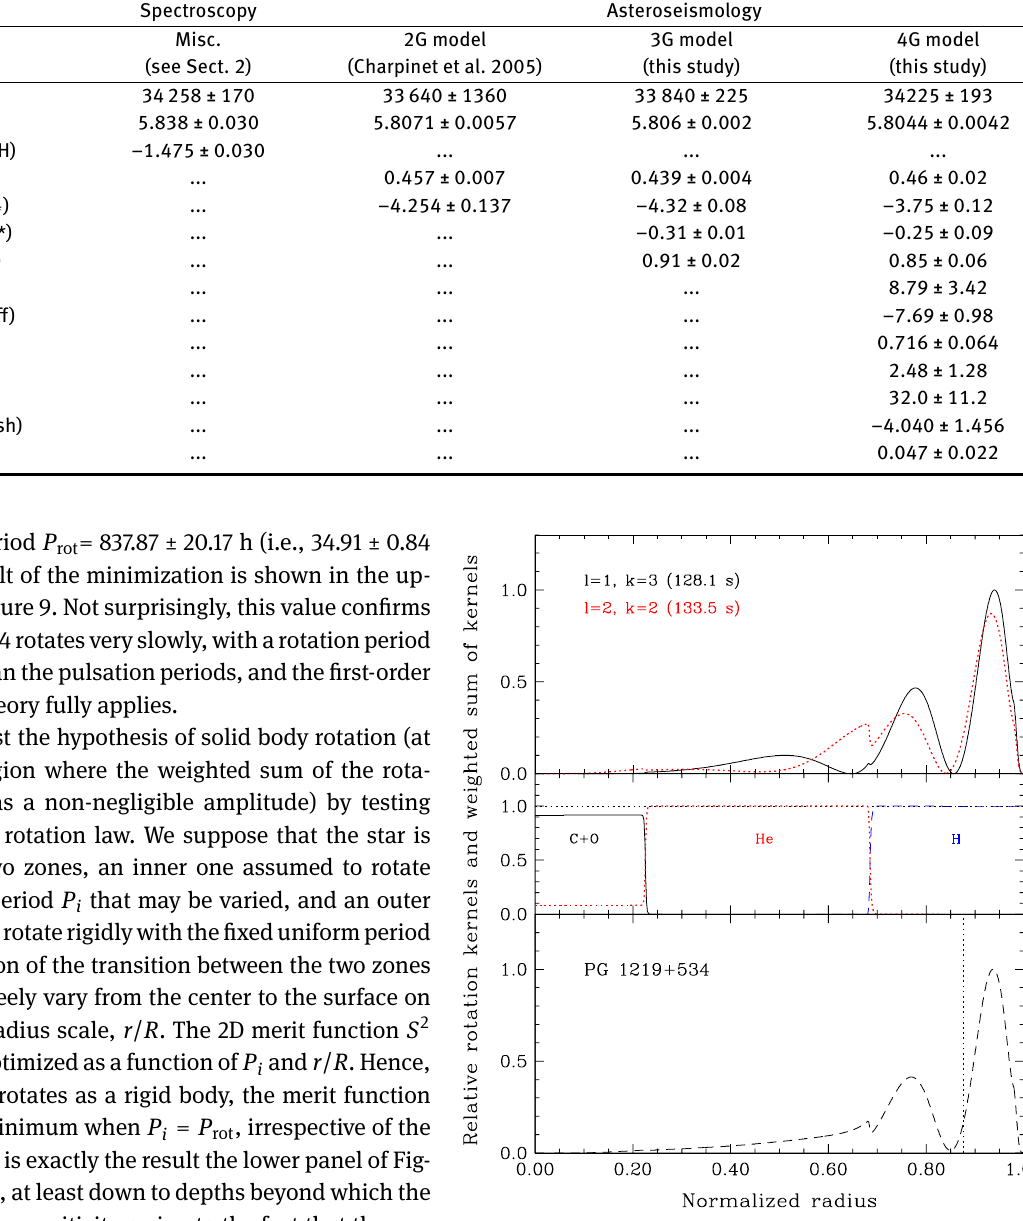
Table 3. Global and internal parameters of PG 1219+534 derived from spectroscopy and asteroseismology. Quantity